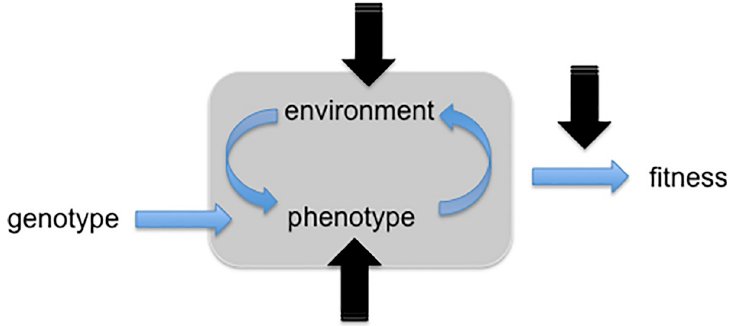
Fig 1. Schematization of the components of an evolutionary systems subject to variations. The genotype determines the characteristics of the phenotype (solution). The continuous interactions between the phenotype and the environment produce a behavior (represented by the grey rectangular area). The fitness indicates the efficacy of the behavior. As indicated by the black arrows, variations might affect the phenotype (i.e. the internal environment), and/ or the environment (i.e. the external environment or the relation between the agent and the environment), and/or the fitness evaluation. Adapted from Figure 8.3 included in [3].